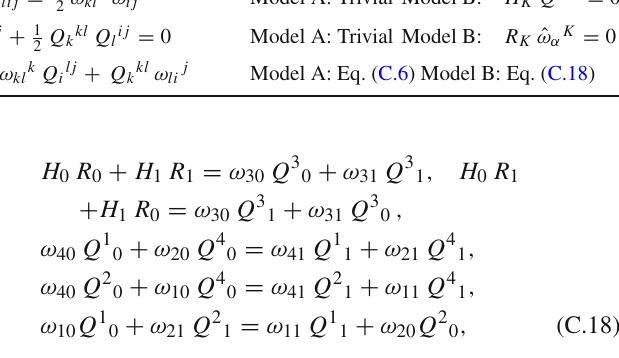
Table 9 A correlation of the weaker first formulation identities in Model A and Model B